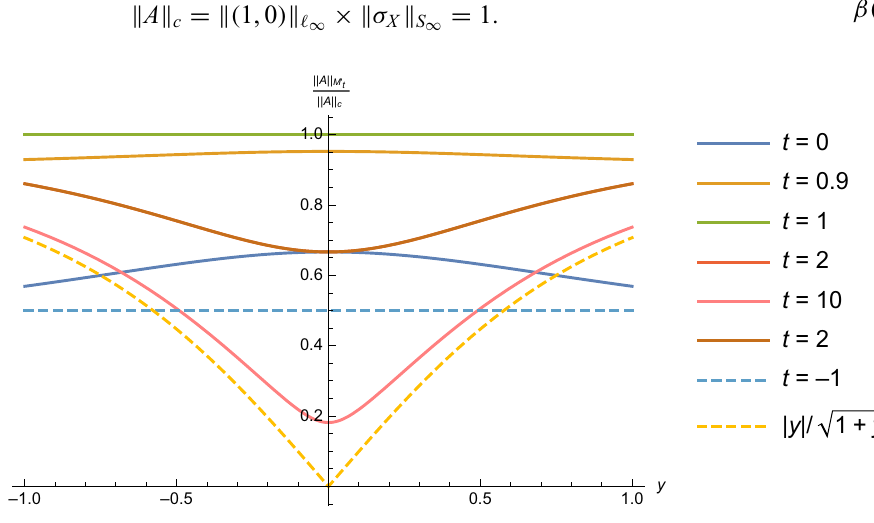
/ (cid:2) A (cid:2) c M (cid:17) t